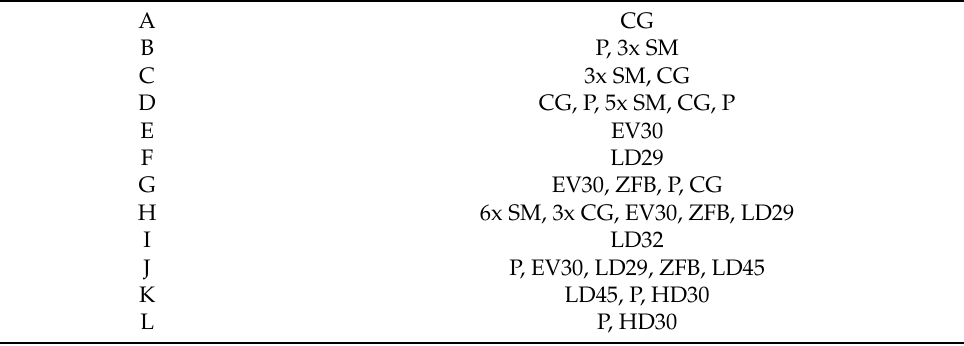
Table A2. Foam combinations used to achieve PLA and durations for